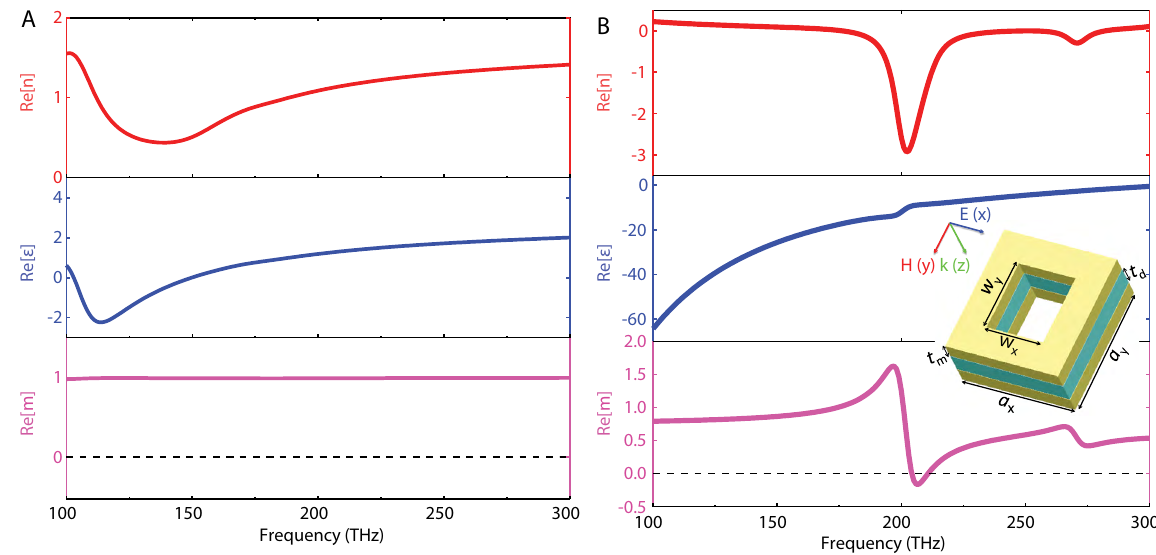
Figure 2 Retrieved real part of effective refractive index [Re(n)], permittivity [Re(ε)], and permeability [Re( μ )] for fishnet structure made by AZO-MgO-AZO (A) and Au-MgO-Au (B), respectively. The fishnet structure [schematically shown as inset of Figure 2(B)] has dimensions = 500 nm, a = 600 nm, w = 200 nm, w = 350 nm, t = 30 nm, and t = 40 nm. a x y x y m d